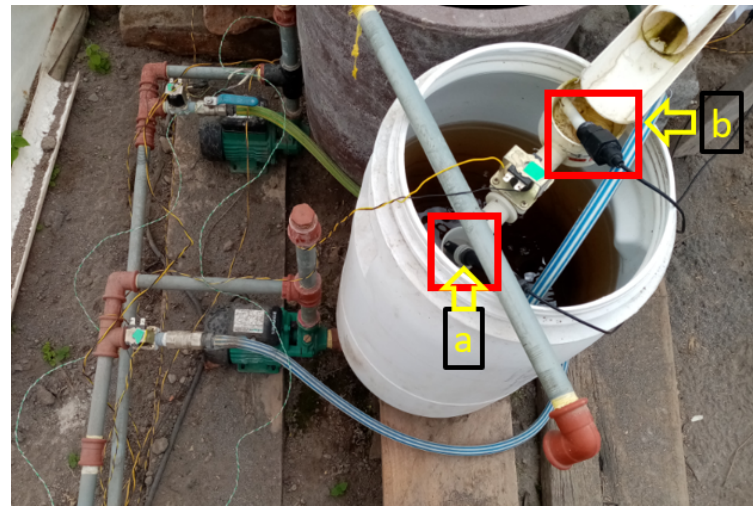
Figure 8. ( a ) Probe for pH; ( b ) probe for electrical